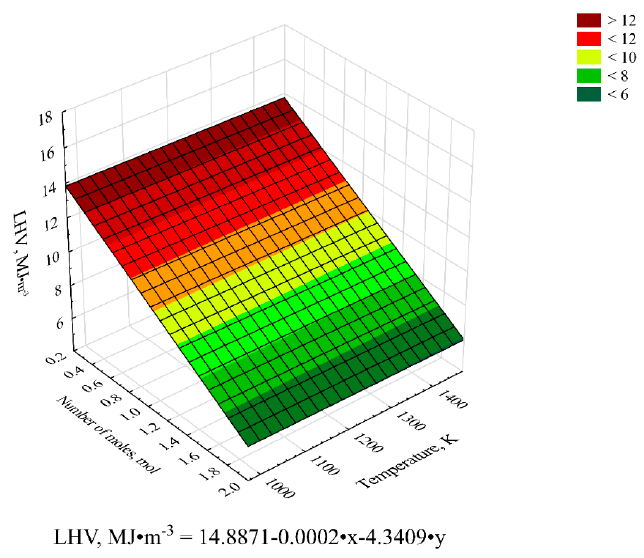
Figure 6. Effect of the number of moles of the gasification agent water vapor (x) and temperature (y) on the heating value ( LHV ) of synthesis gas.